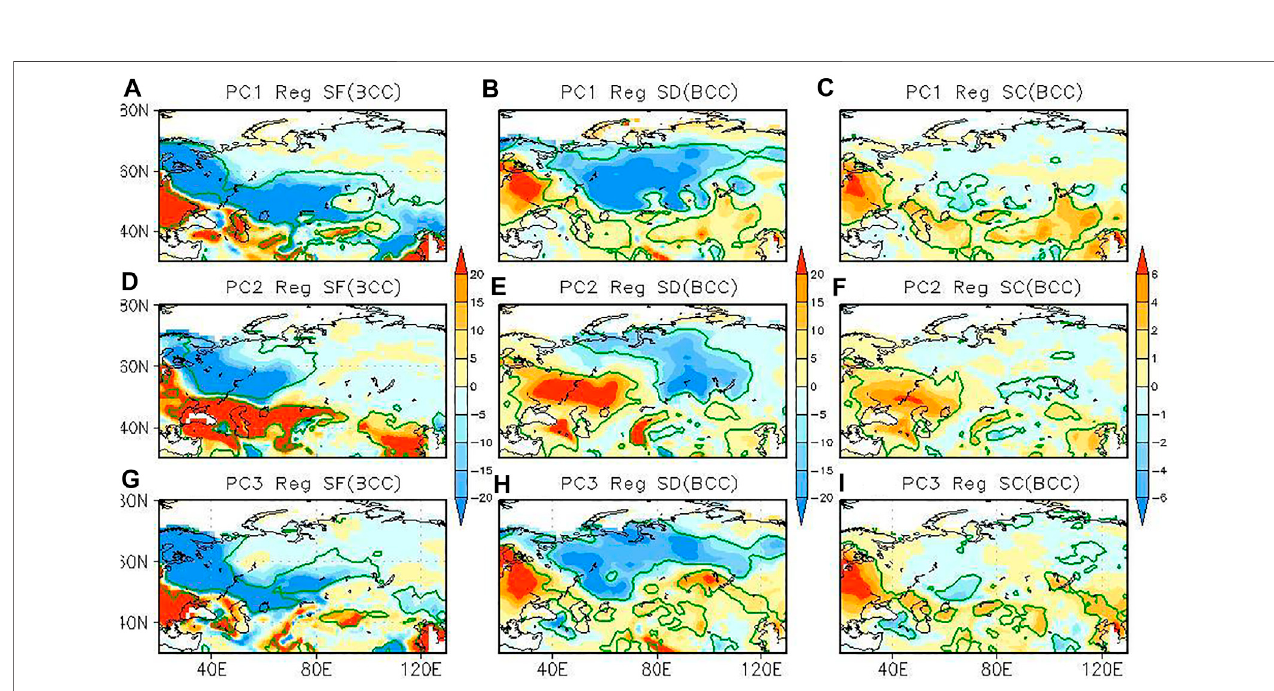
FIGURE13| RegressedanomaliesofDJF (A) snowfall(shading,units:mm), (B) snowdepth(shading;units: mm),and (C) snowcover(shading;units:%)ontothe PC1 index, (D – F) onto the PC2 index, and (G – I) onto PC3 index from BCC-CSM2-MR simulations. The green line indicates the value signi fi cantly exceeding the 95% con fi dence